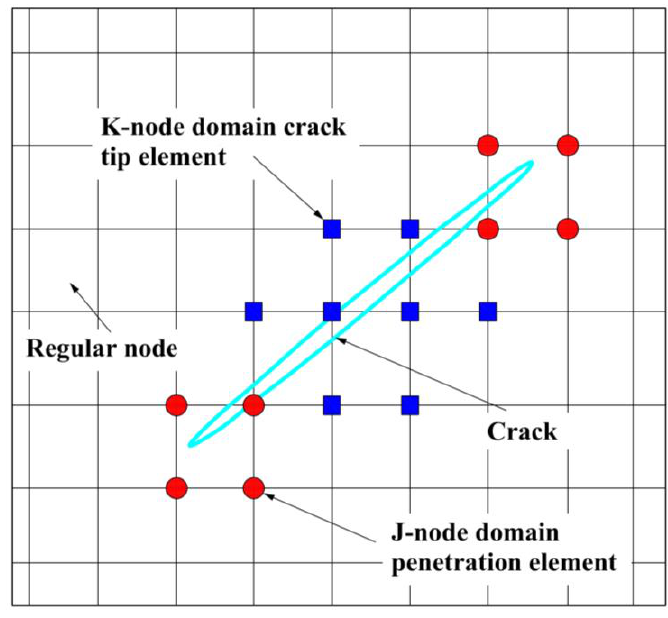
Figure 9. Node domain element with cracks.